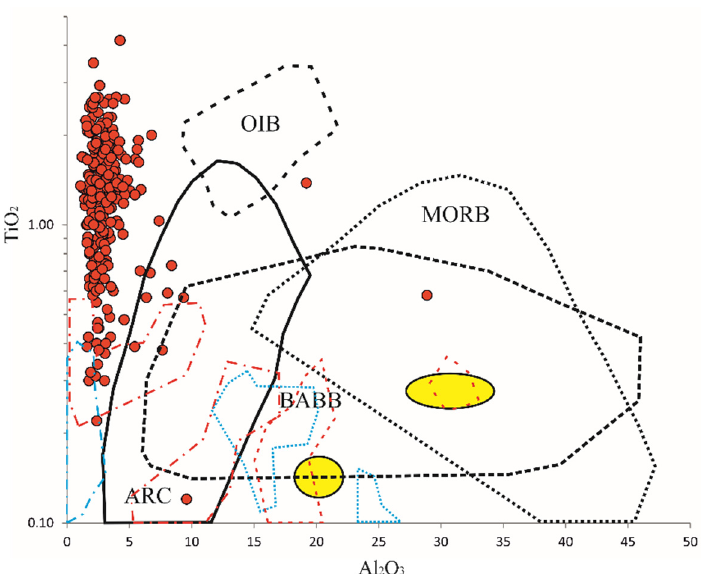
Figure 3. TiO 2 vs. Al 2 O 3 diagram. Red circles: Cr-spinels from Kinnekulle (this study); yellow fields: Cr-spinels from Ballantrae ophiolites [41]; red dotted lines: Cr-spinels from Shetland ophiolites [42]; red dot and dash lines: ferrian-chromite rims of Cr-spinels from Shetland ophiolites [42]; blue dotted lines: Cr-spinels from Leka ophiolites [43]; blue dot and dash lines: ferrian-chromite rims of Cr-spinels from Leka ophiolites [43]. Fields for Arc, OIB (ocean island basalts), BABB (back arc basin Basalts), and MORB (mid ocean ridge basalts) after [12,19].